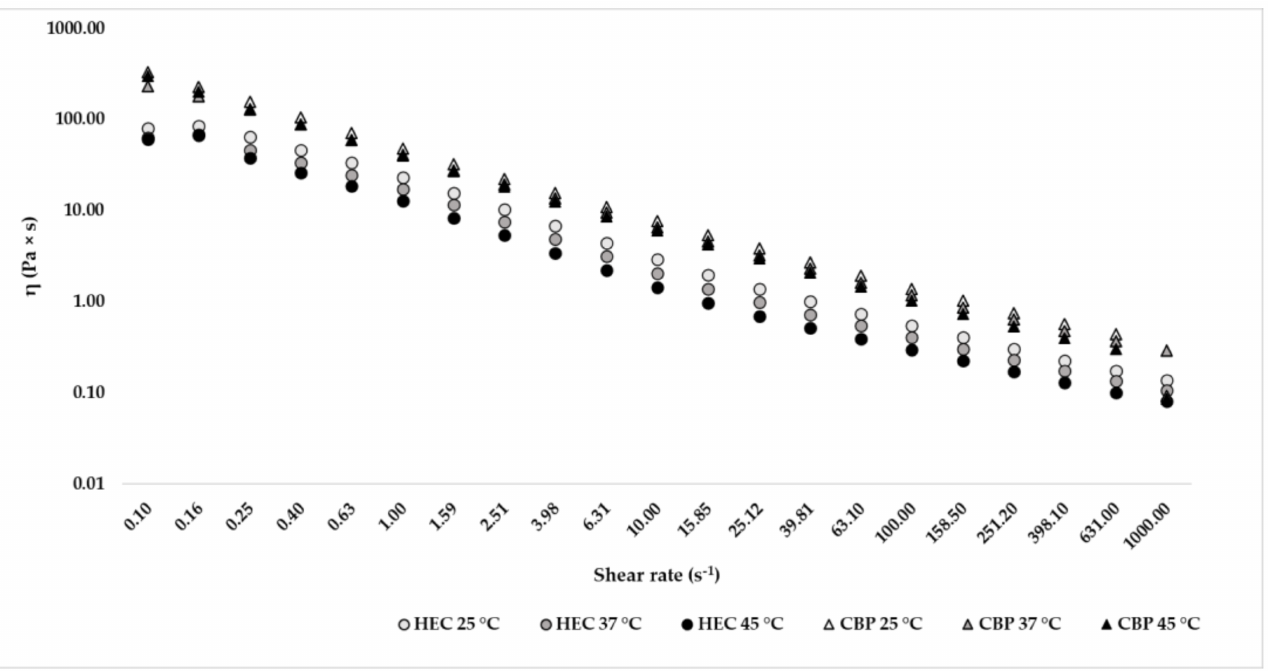
Figure 4. Graphical representation of the viscosity trend of the formulation with hydroxyethylcellu- lose (HEC) and formulation with carbopol (CBP) at temperatures of 25, 37, and 45 ◦ C with increasing shear rate (s − 1 ).